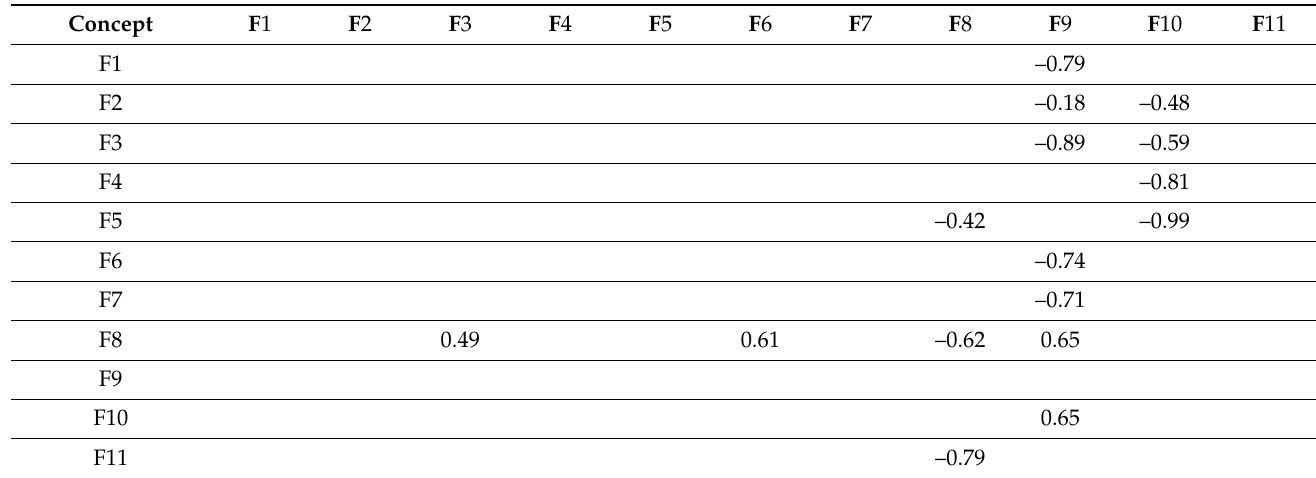
Table 1. Contiguity matrix of fuzzy cognitive map of bank cybersecurity.